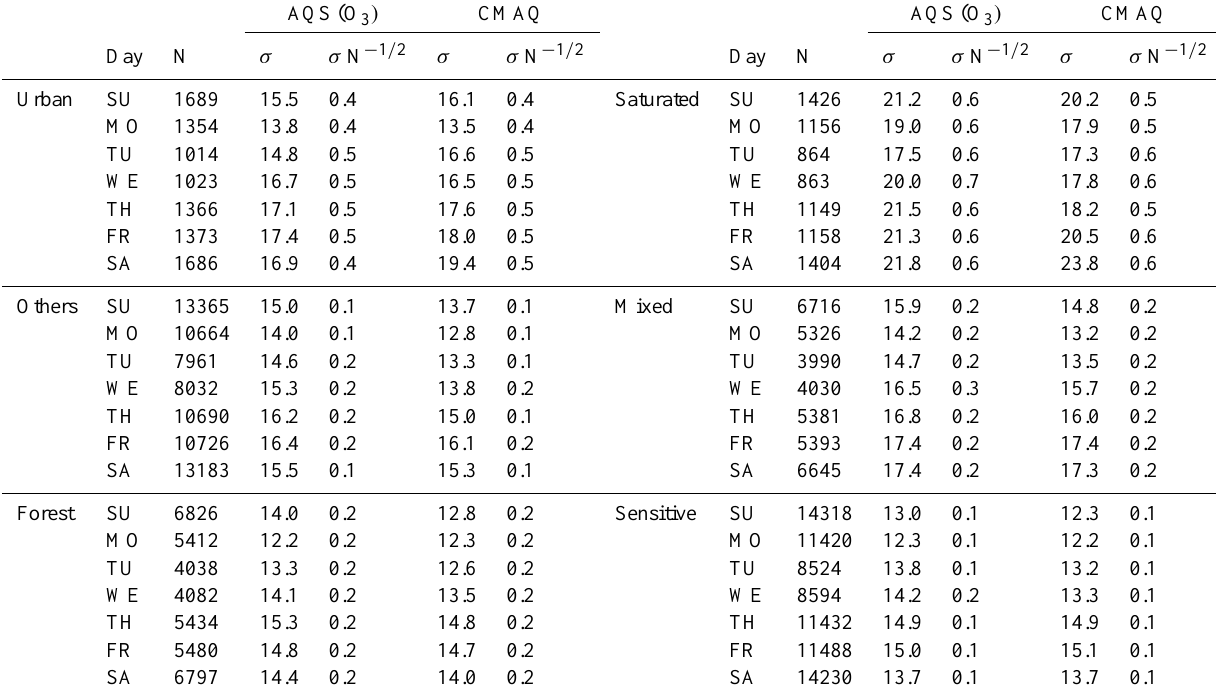
Table 3. The number of data (weekly anomaly), the standard deviation, and the standard error of the mean (SEM) of EPA AQS observa- tions and CMAQ simulations for O 3 measurement sites over the AVHRR-derived geographical regions and the GOME-2-derived chemical